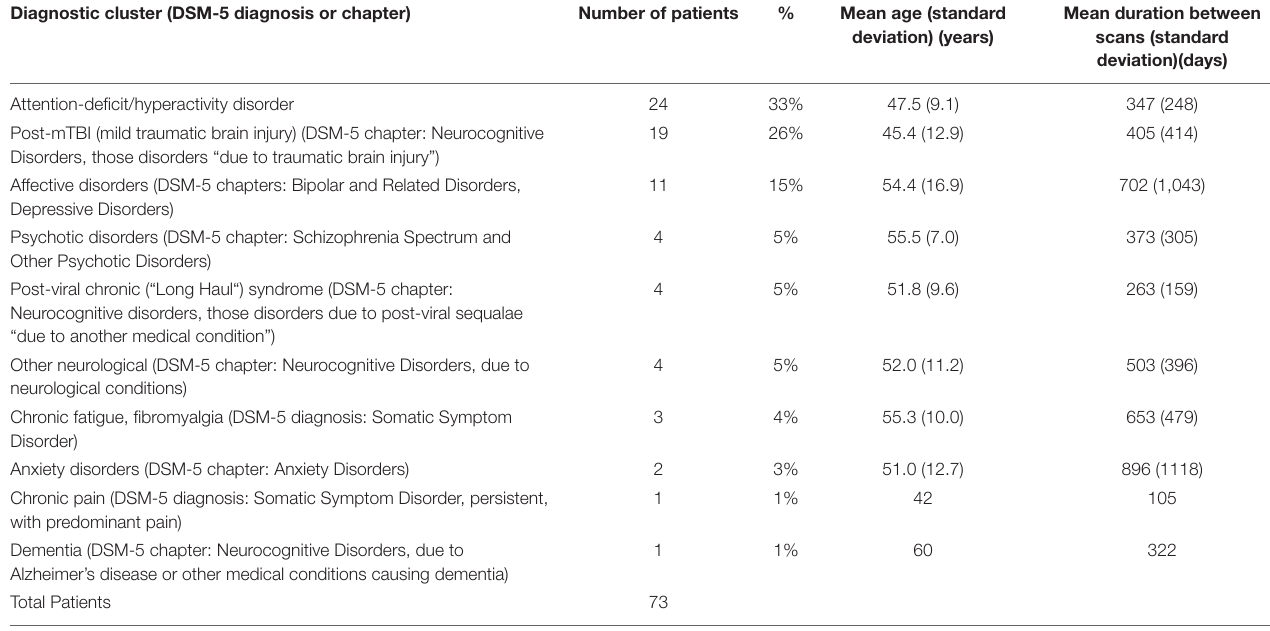
TABLE 1 | Patient diagnoses.